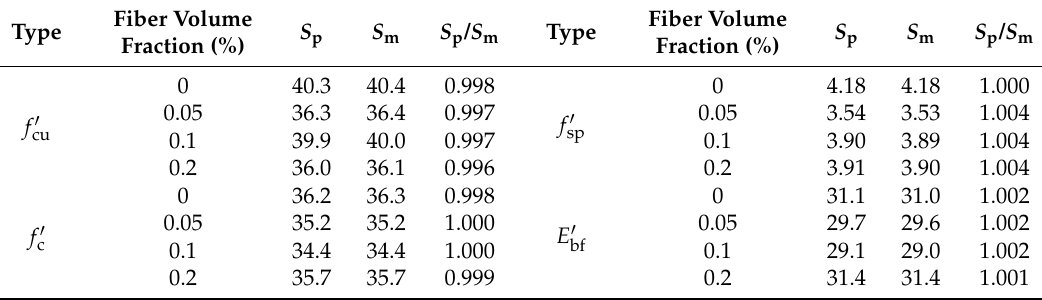
Table 9. Comparison between strength formula predictions and test